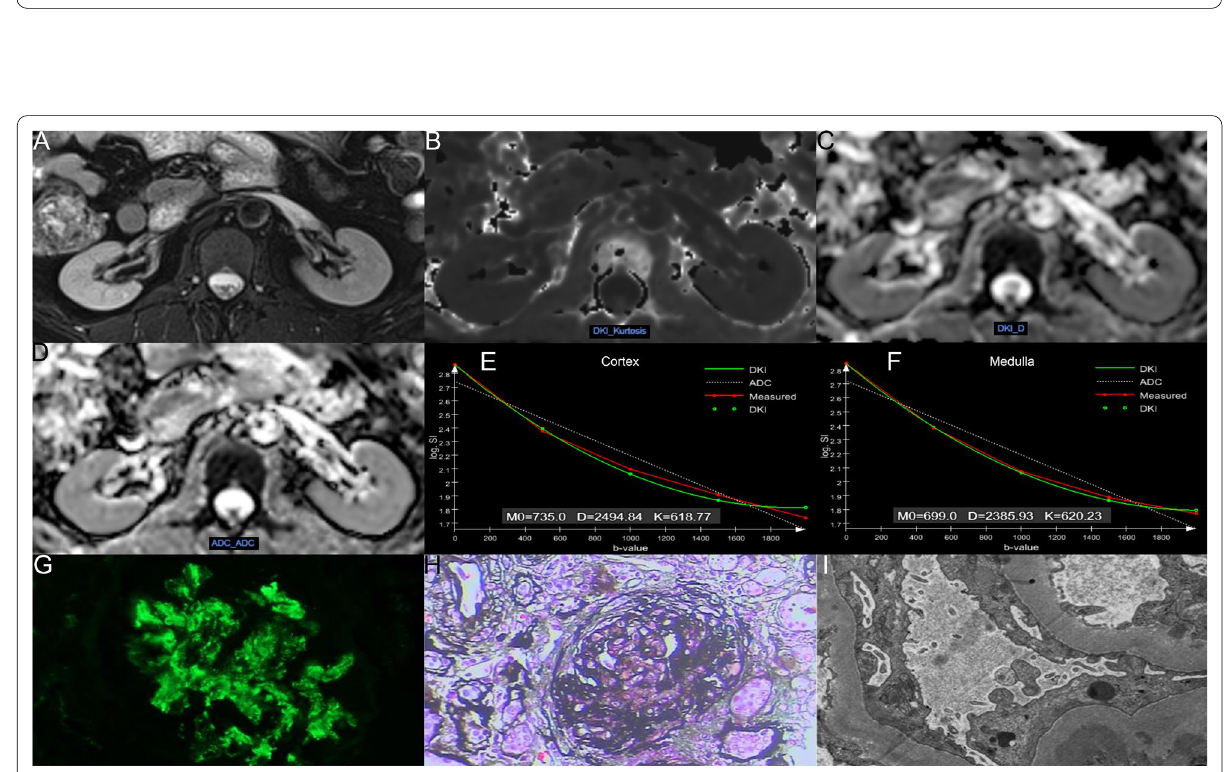
Fig. 3 Respective MRI and pathological images of the IgAN patients with eGFR cortex DKI fit, medulla DKI fit, immunofluorescence, light microscopy, and electron microscopy, respectively. The pathological result of this patient is M0E0S1T1C1